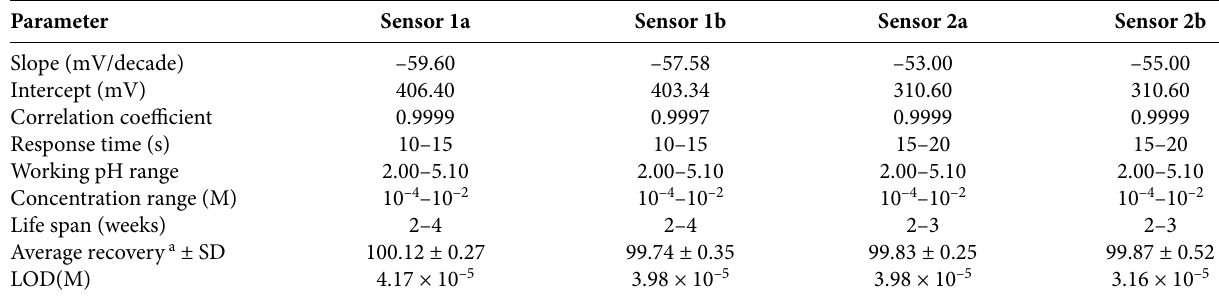
Table 1. Response characteristics of the investigated sensors. Parameter